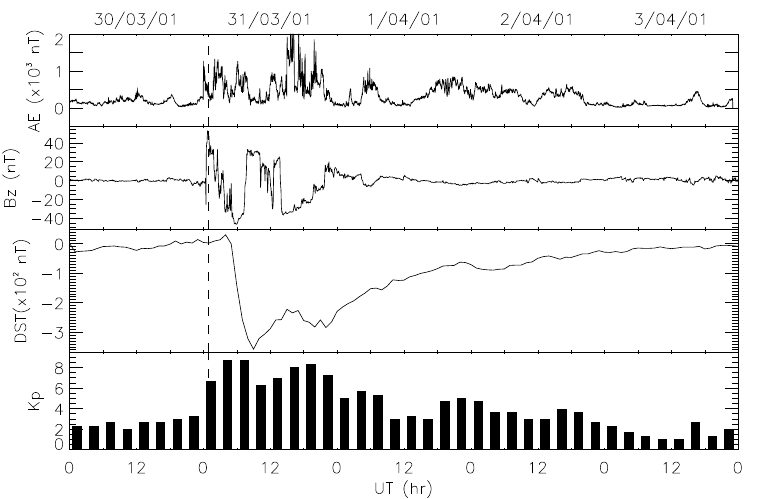
Fig. 2. Variation of geomagnetic indices: AE -index, IMF B z -component, D st and K p indices are shown from top to bottom panels, respectively. The dashed vertical line depicts the Storm Sudden Commencement (SSC) of the 31 March